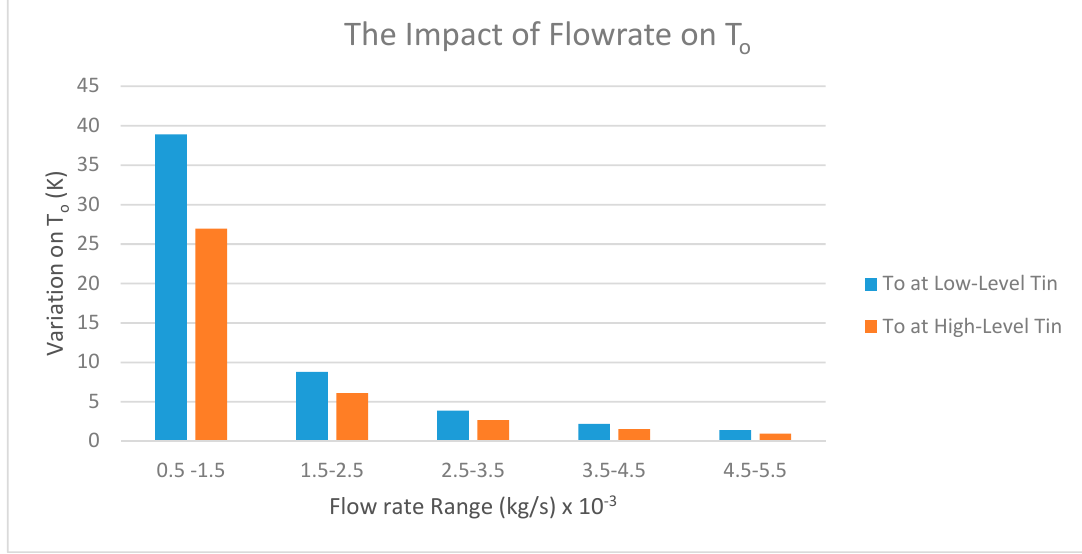
Figure 7. The impact of flow rate on the variation water temperature for different range of flow rate. A maximum increase in (T o − T in ) of 62 K occurred at the minimum flowrate inside the riser ( (cid:1865) (cid:4662) = 5 × 10 − 4 kg/s) at Low-Level inlet temperature while the minimum of 6 K occurred at the maximum flowrate ( (cid:1865)(cid:4662) = 60 × 10 − 4 kg/s) as in Figure 8.